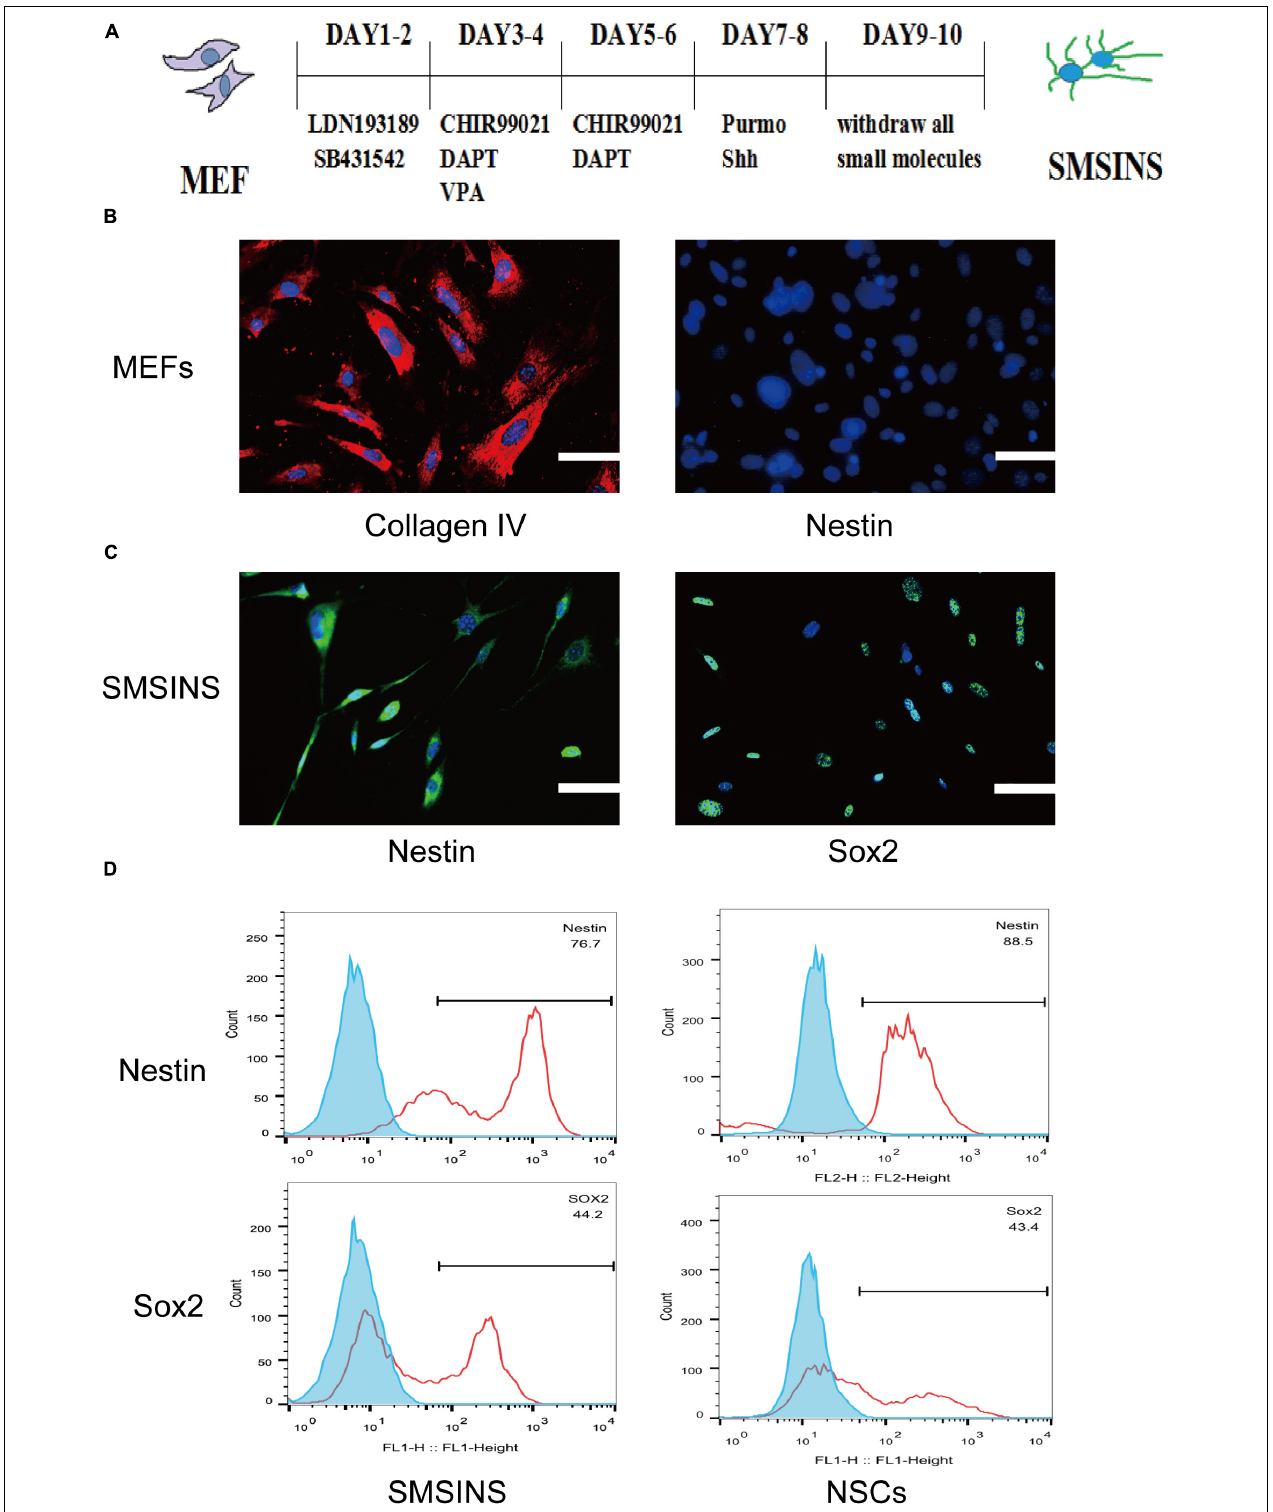
FIGURE 1 | Induction of SMSINS from MEFs. (A) Schematic diagram of the SMSINS induced process. (B) MEFs express fibroblast markers without NSC markers. MEFs were stained with specific antibodies against Collagen IV (Red) and Nestin (Green). (C) Immunostaining of Nestin (Green) and Sox2 (Green) in SMSINS at day 10 using a specific antibody. Nuclei were counterstained with DAPI (blue). (D) Flow cytometric analysis to quantify cells expressing Sox2 and Nestin after SMSINS induction and native NSC cells isolated from embryonic mouse brain. Scale bars: 100 µ m (B,C) .